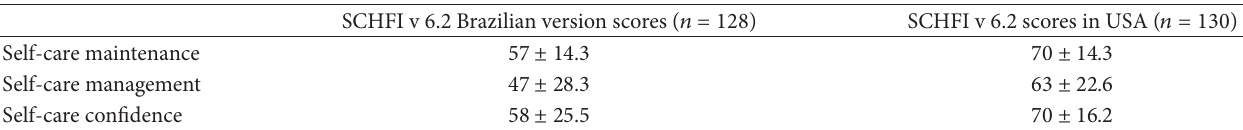
Table 2: Scores obtained with the Brazilian version of the self-care of heart failure index v 6.2 and with the original self-care of heart failure index version